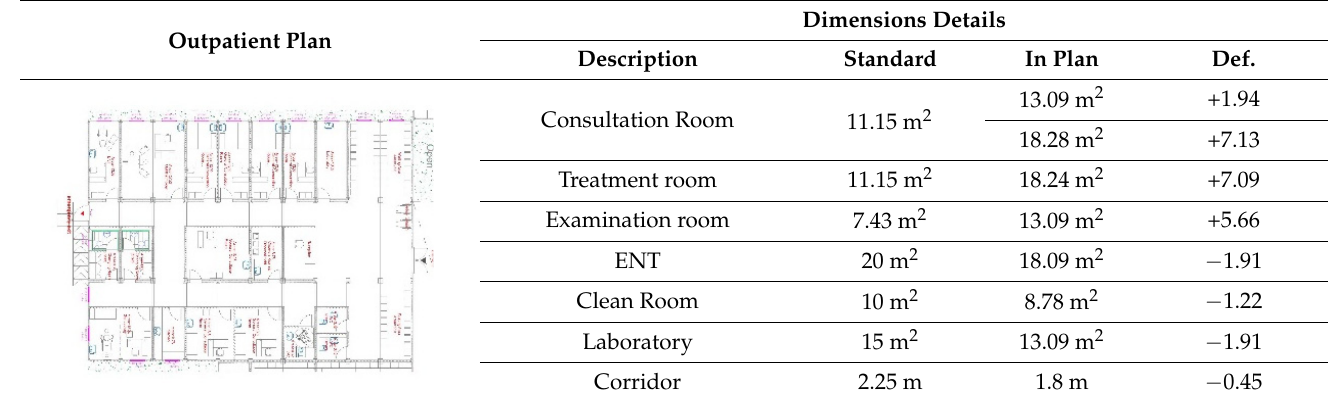
Table 5. Dimensional requirements of the outpatient department compared to standards. Table 6. Dimensional requirements of the radiology department compared to standards.